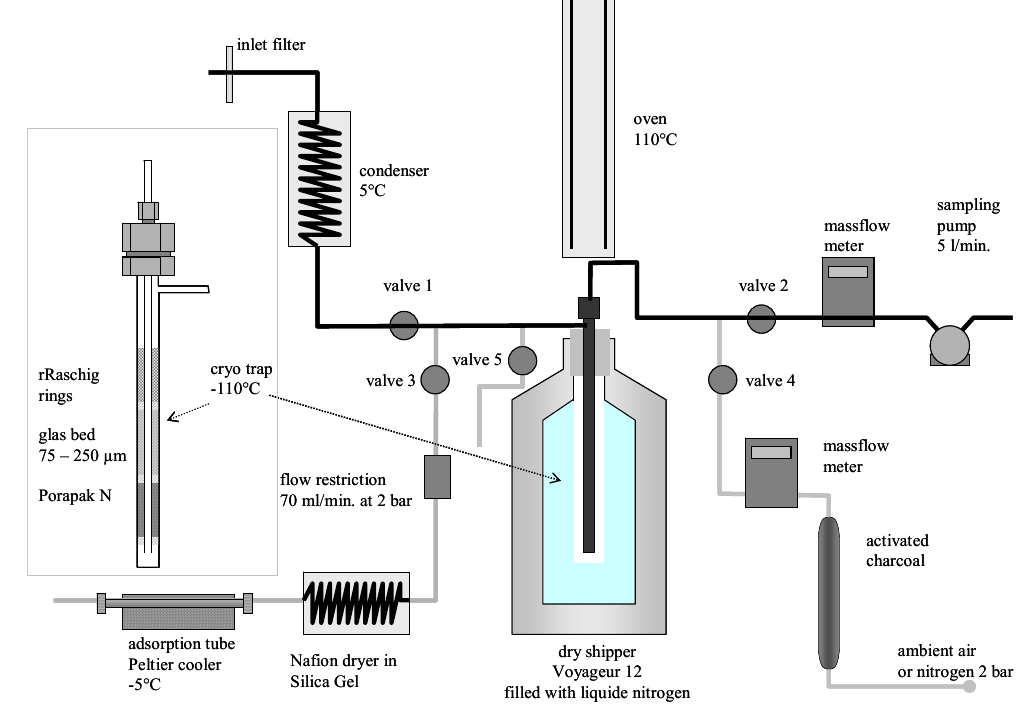
Fig. 2. Scheme of the analytical system. Figure 2. Scheme of the analytical system flow were transferred to an DeltaV isotope ratio mass spec- trometer via an open